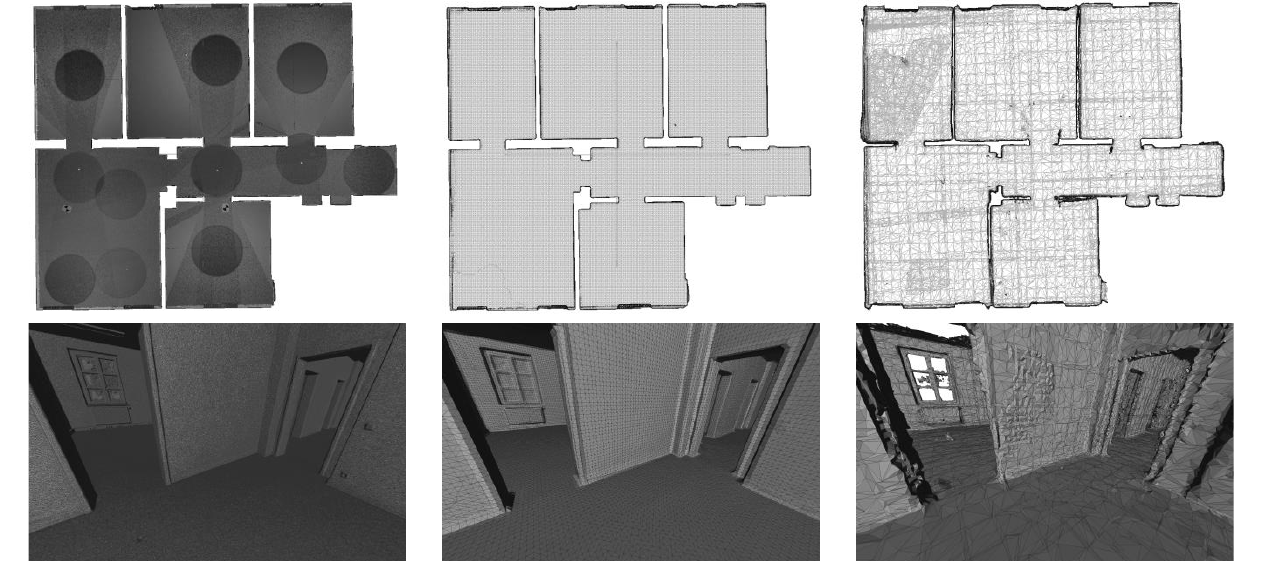
Figure 1. The considered scene representing an empty apartment in nadir view (top row) and in detailed oblique view (bottom row): raw TLS data (left), TLS data downsampled via a voxel-grid filter using a voxel size of 3 cm (center), and HoloLens data